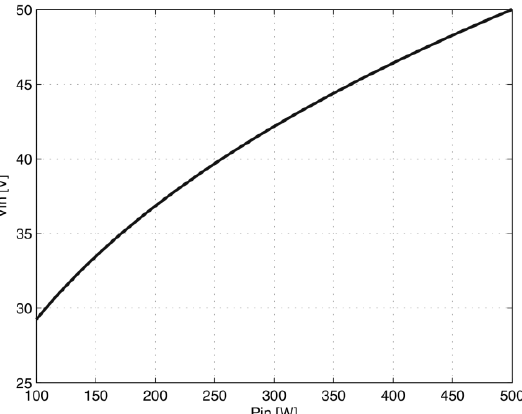
Figure 7. Relation between input voltage and input power in push – pull converter (PM wind turbine).